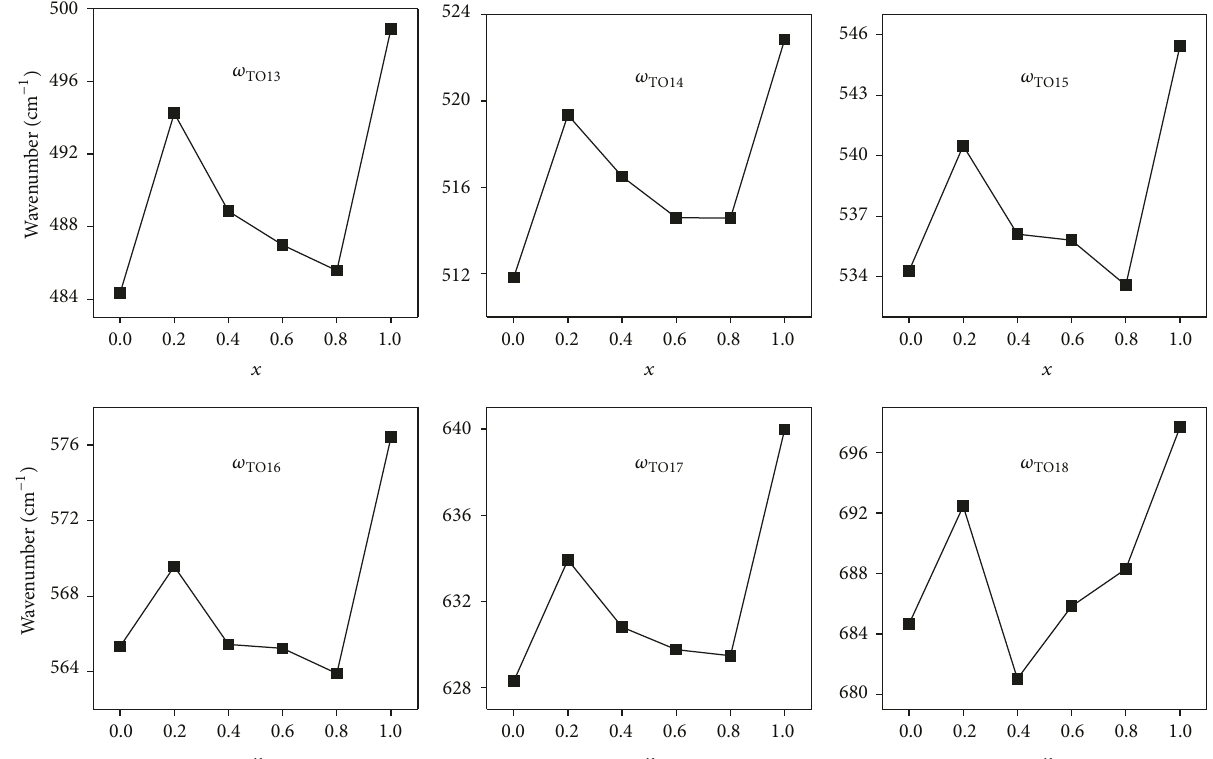
Figure 5: Transverse optical frequency ( 𝜔 TO ) of the high frequency phonon mode 𝜔 TO 13 to 𝜔 TO 18 as a function of concentration 𝑥 .